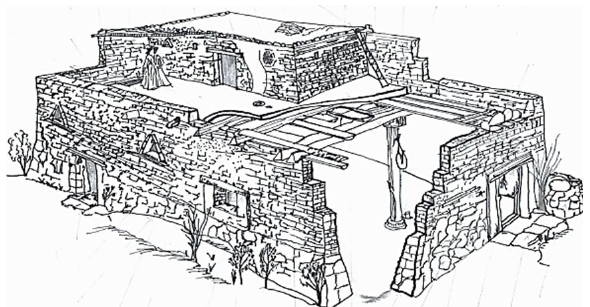
Figure 6. Traditional Berber house, sample of a typical Shawia dwelling (developed by Authors from analysis and Daniele Jemma (1989) studies)